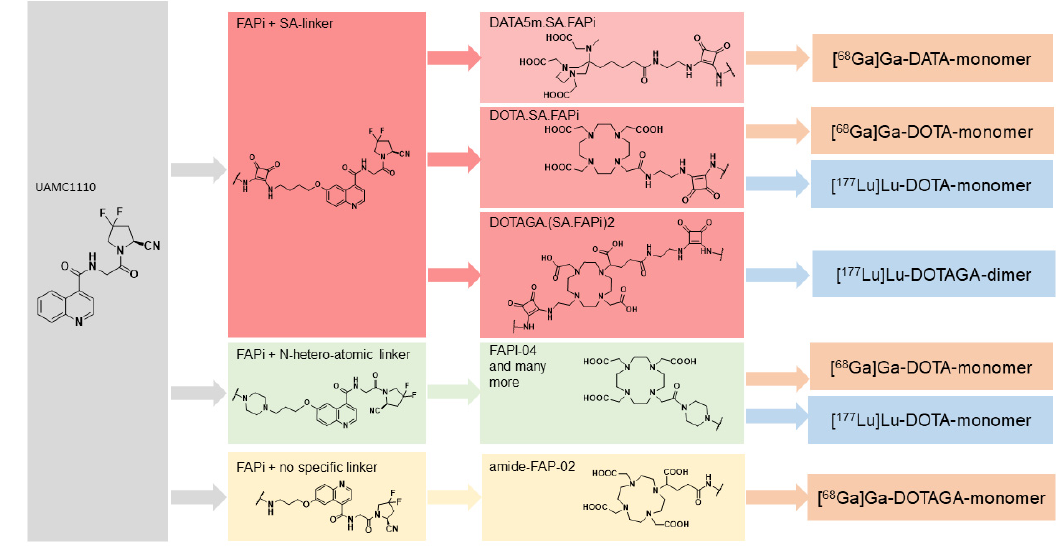
Figure 1. Generations of chelator–linker FAP inhibitor conjugates, a step towards development of FAP-targeted theranostics.